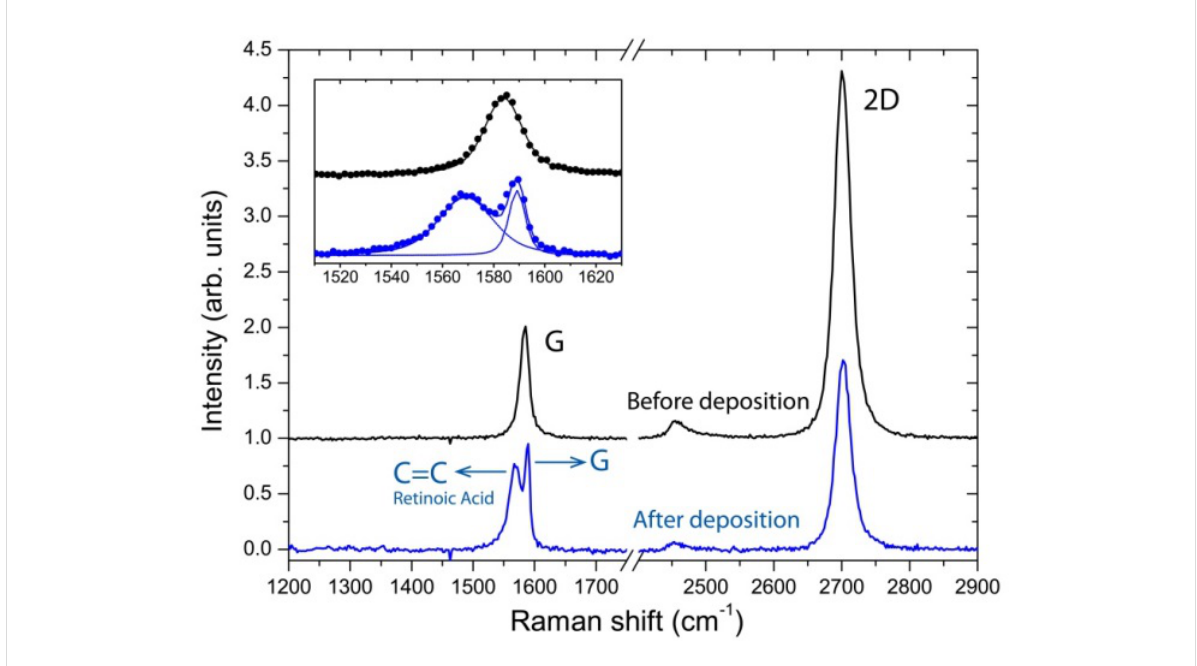
Figure 6: Raman spectroscopy data. Raman spectra obtained from the same region of a graphene monolayer before (black) and after (blue) deposi- tion of RA molecules. For a better visualization, the inset at the top left shows the superposition of the G band obtained for both cases. The Raman mode at ≈ 1570 cm − 1 originates from C=C RA molecule